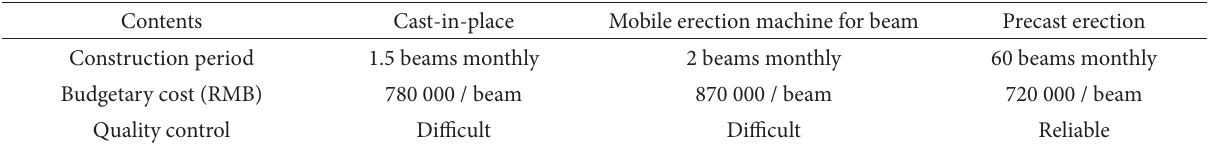
Table 4. Comparison of construction